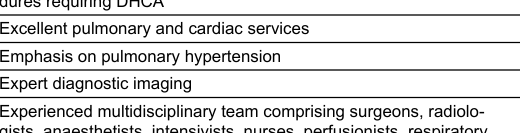
Table 1: Characteristics of an expert centre. Reproduced with per- mission of the European Respiratory Society © . Eur Respir Rev. 2017;26 (143):160111 [75]. Extensive experience with cardiothoracic surgery, including proce- dures requiring DHCA Excellent pulmonary and cardiac